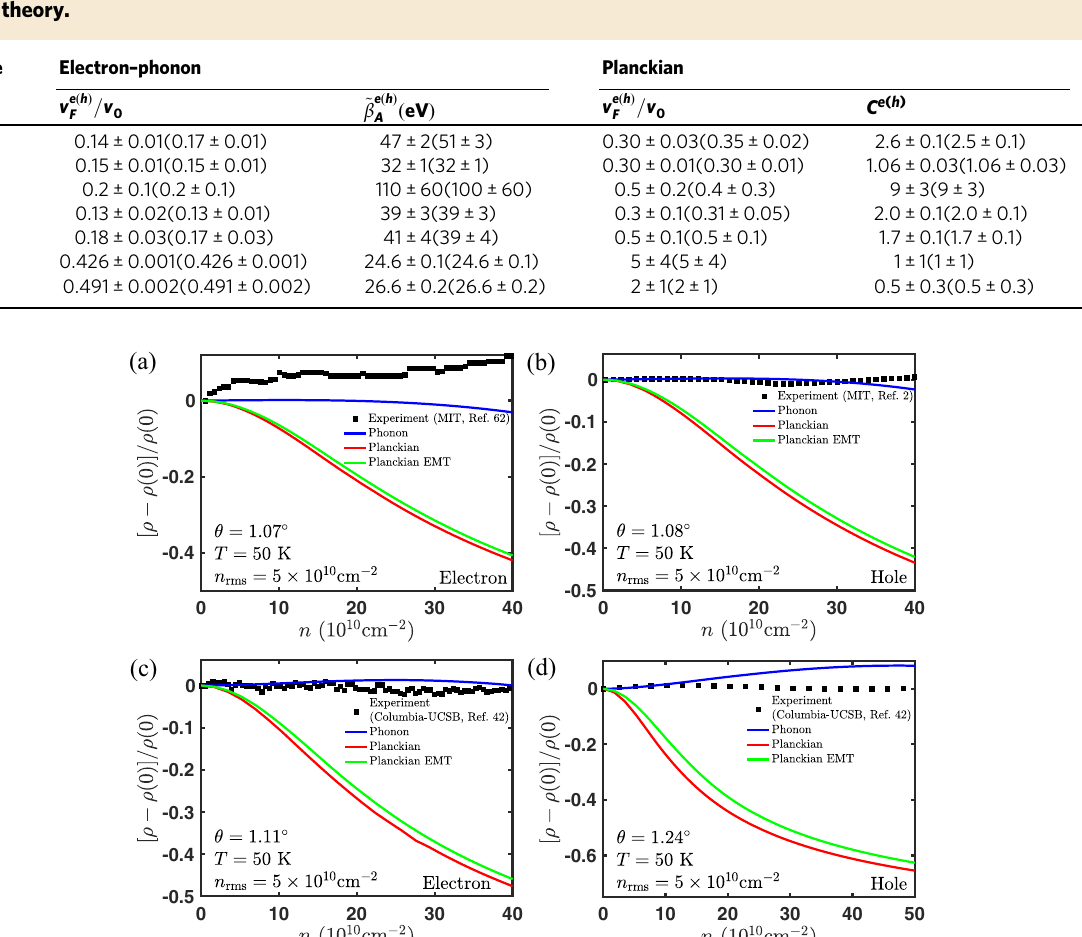
~ β – phonon theory and Fermi velocity ( v A Þ for electron